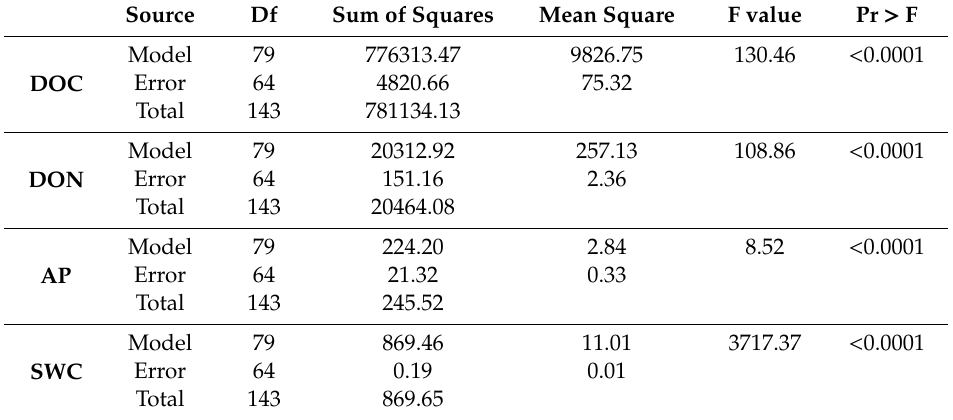
Table 2. ANOVA tables of available nutrients and water content. Factors include years (April, June, August, and October), lands (CK40, CK30, CK15, and SC) and soil depth (0–10, 10–20, and 20–30 cm).